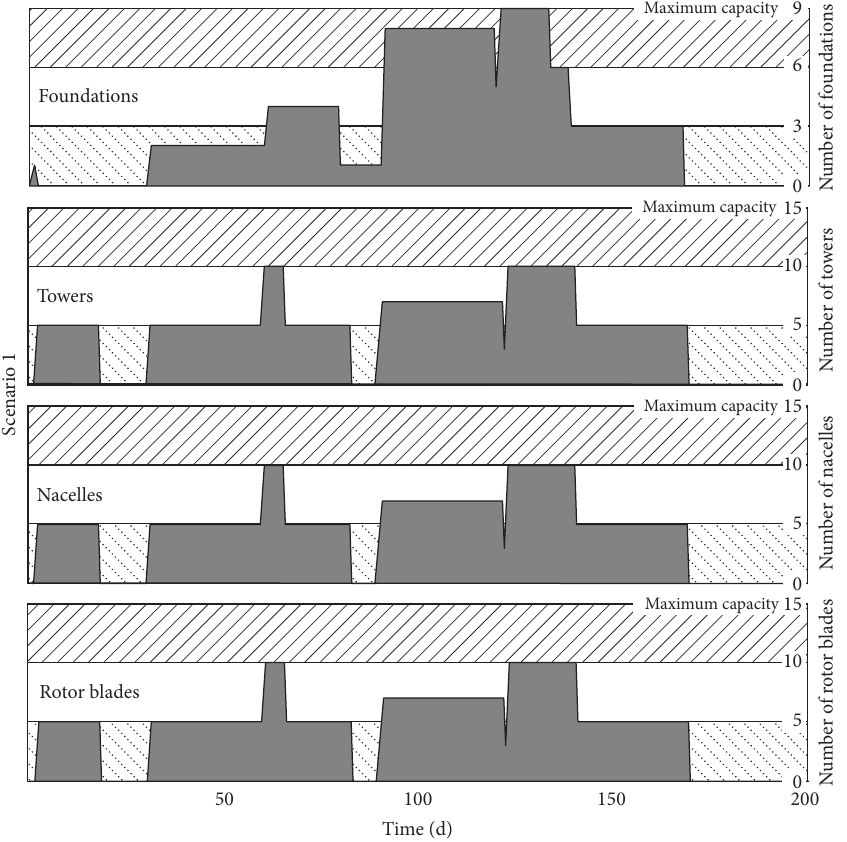
Figure 4: Simulation results of Scenario